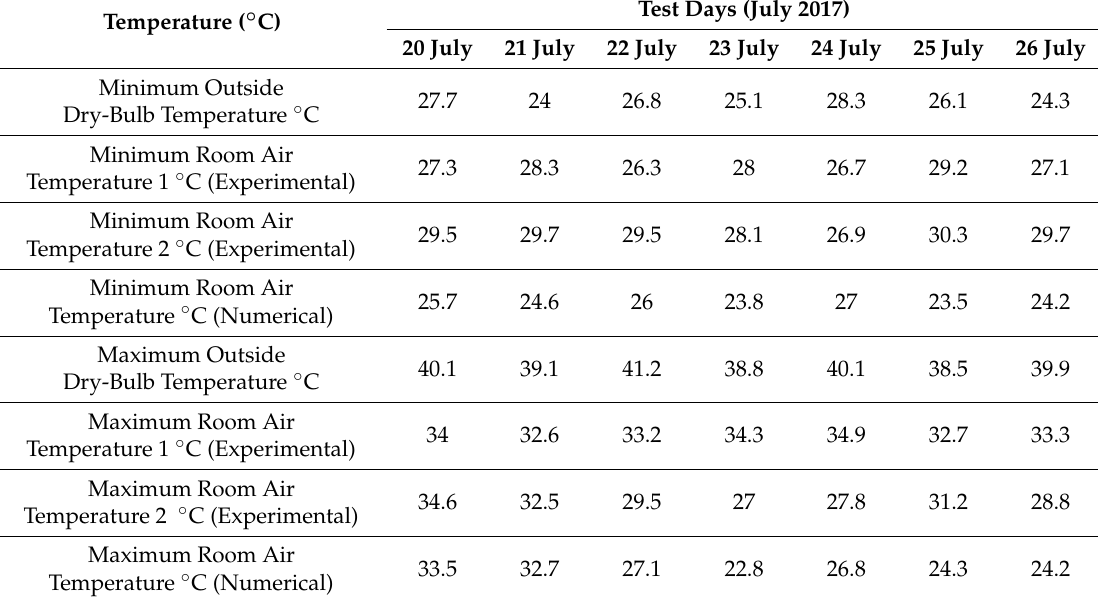
Table 6. The hourly results comparison of the experimental and simulation model in